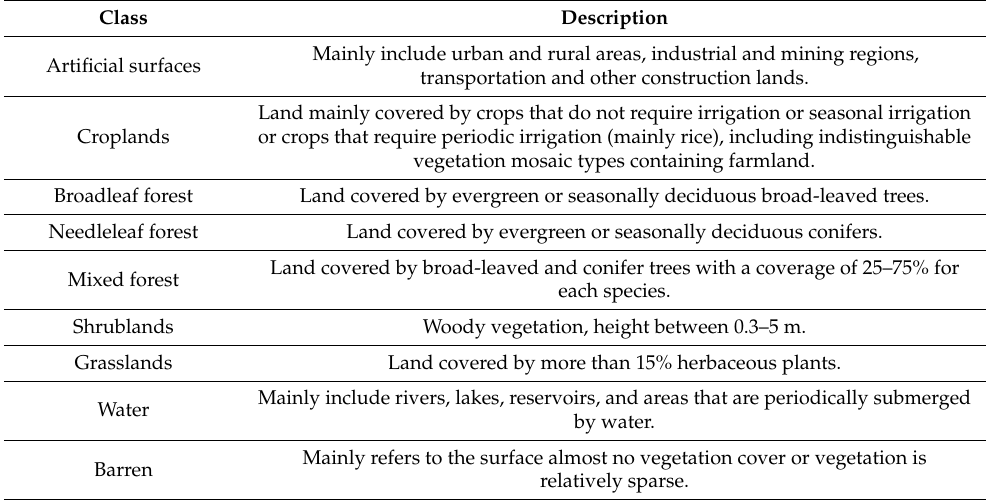
Table 1. Classification and Description of Land Use/Cover in the Selenga River Basin.